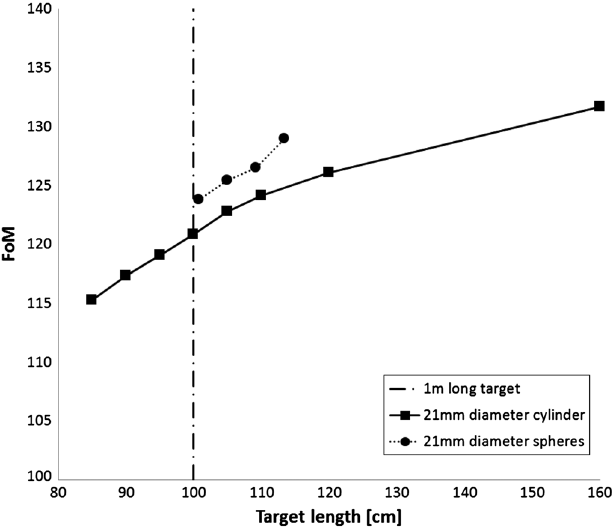
FIG. 10. Transient thermal simulation of minimum and maxi- mum beryllium temperature following 21 beam